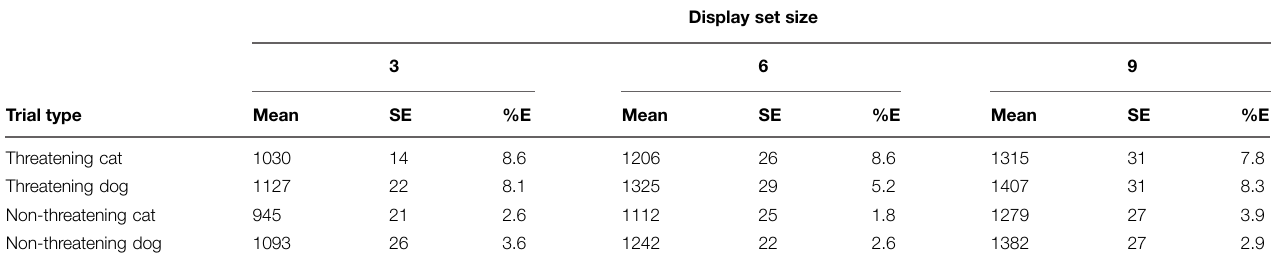
TABLE 4 | Mean RTs, SE, and mean percentage error rates (%E) for the various conditions of interest in the classification task in Experiment 2.